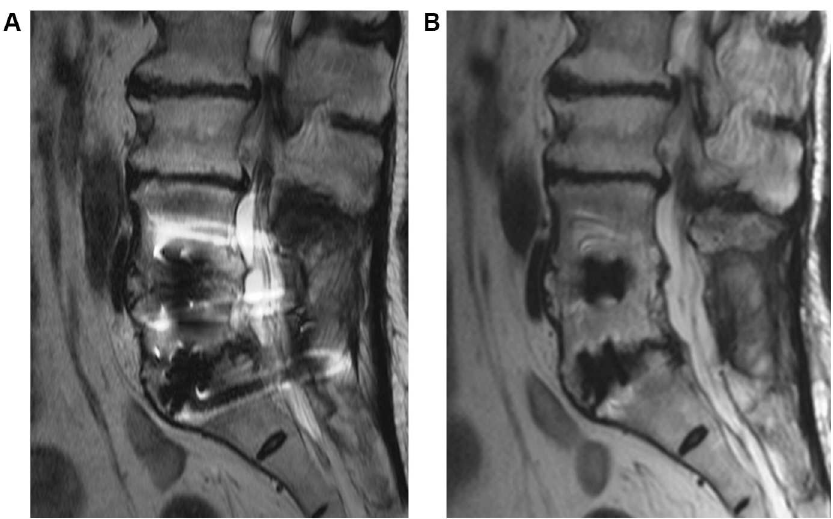
Fig 4. Visibility score of bone-cage interface and diagnostic confidence of inter-body non-union in sagittal images. These two sagittal images are obtainedfrom a 72 year old female who underwent inter- body fusion at L4-5 and L5-S1 and posterior instrumentation at L4-S1 level due to spinal stenosis. The time interval between surgery and the spine MRI was 1 years and 3 months. (a) Sagittal Fast spin echo T2 weightedimage shows grade 1, 1 (observer 1) and 1, 1 (observer 2) at L4-5 and grade 1, 1 (observer 1) and 1, 1 (observer 2) at L5-S1 of interface between upper and lower margin of the cage and bone marrow. (b) Sagittal FSE-SEMAC T2 weightedimage shows grade 3, 2 (observer 1) and 2, 2 (observer 2) at L4-5 and grade 3, 2 (observer 1) and 2, 2 (observer 2) at L5-S1 of interface between upper and lower margin of the cage and bone marrow. Diagnostic confidencelevel was grade 3 (inconclusive, observer 1) and 2 (suspiciously absent, observer 2) in FSE T2 weightedsagittal image, but after applicationof FSE-SEMAC, diagnosticconfidence level was enhancedto grade 2 (suspiciously absent, observer 1) and grade 1 (definitelyabsent, observer 2),